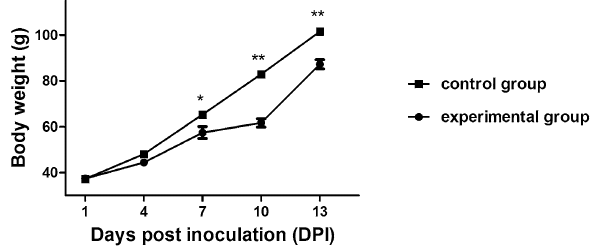
Figure 3. Body weight changes for chickens infected with NDRV by the s.c. route. The experimental group chickens were infected with 100 µL × 10 5.00 ELD 50 /0.1 mL of NDRV. The control group chickens were infected with 100μL PBS (pH 7.0). Bars show means ± standard deviation (SD). The mean value was statistically significant, determined using by the two-tailed Student’s unpaired t-test (*P < 0.05 and **P < 0.01).